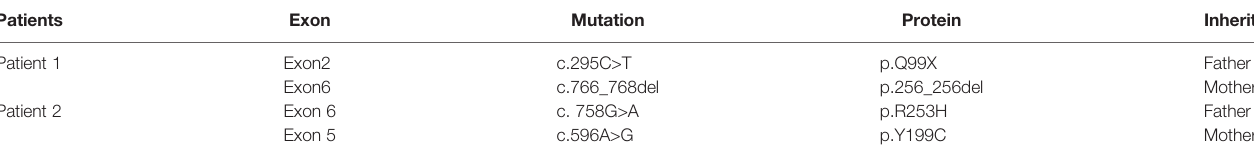
TABLE 4 | G6PC3 gene mutation status in patients and their parents. Patients